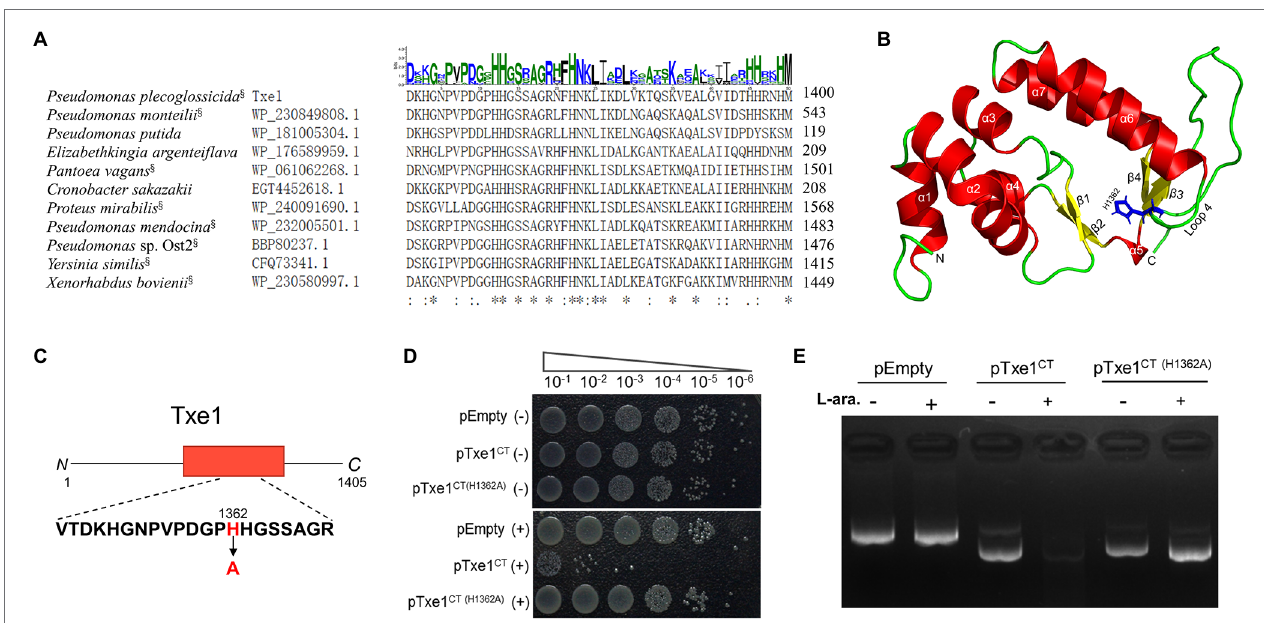
FIGURE 4 | Mutation of H1362 abolishes toxicity of Txe1. Partial sequence alignment of Txe1 CT region with representative hits of BLASTp analysis (A) . In each case, the species name and accession number are on the left, and the numbering for the last residue is on the right. CT domains that are linked to N terminal Rhs domain are indicted with a superscript “§” behind the species name. On the top is the sequence logo representation of the aligned region of 50 residues (this region contains all the identical histidine residues in the protein sequence alignment of Txe1 CT domain with the 100 best BlastP hits.). Consensus sequences were plotted with WebLogo web-based tool (http://weblogo.threeplusone.com/create.cgi). Height of letter indicates degree of conservation. Residues identical in all species are indicated by “*” on the bottom. AlphaFold2-generated tertiary structure models for the CT domain of Txe1 (B) . Txe1 CT domain is colored by secondary structure: helices (red), sheets (yellow), and loop (green). A tertiary structure similar to the His-Me finger from caspase-activated DNase (PDB ID: 1v0d) is formed by sheets β 3 and β 4 and helices α 6 and α 7. Schematic representation indicating the mutation site of Txe1 (C) . Mutation of histidine 1,362 to alanine (H1362A) in Txe1 abolishes toxicity (D) . Growth of E. coli BL21(DE3) carrying empty pBAD33.1 (pEmpty) or plasmids directing the expression of the Txe1 CT domain or mutant on LB agar (E) . + And − symbols indicate addition or not of 0.2% L-arabinose, respectively. The experiment was repeated twice with similar results, and the results from one representative experiment are